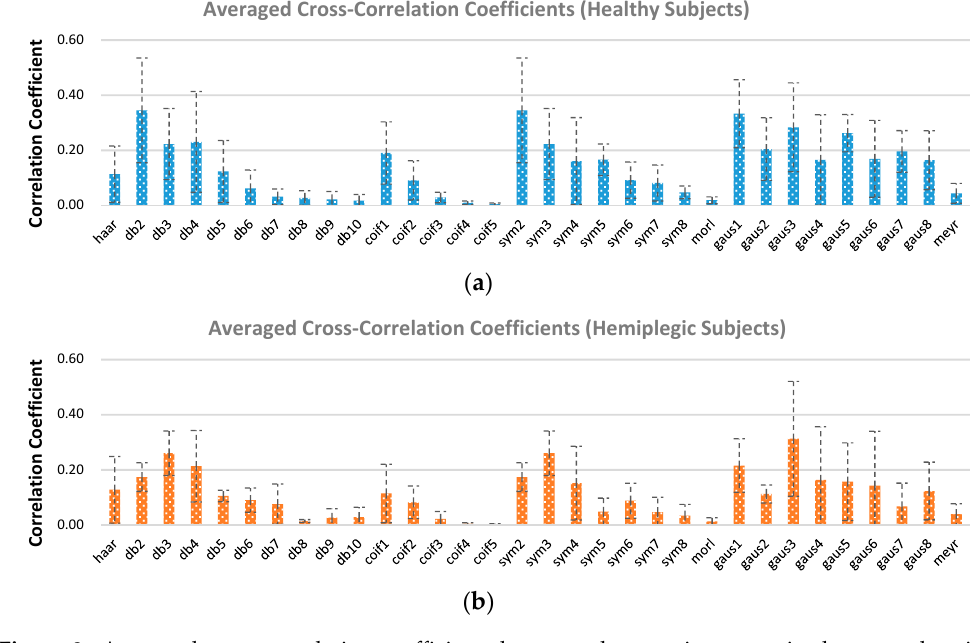
Figure 8. Averaged cross-correlation coefficients between the anterior–posterior knee acceleration signal and specific mother wavelet function for healthy subjects ( a ) and hemiplegic subjects ( b ). Vertical dotted line indicates the standard deviation.